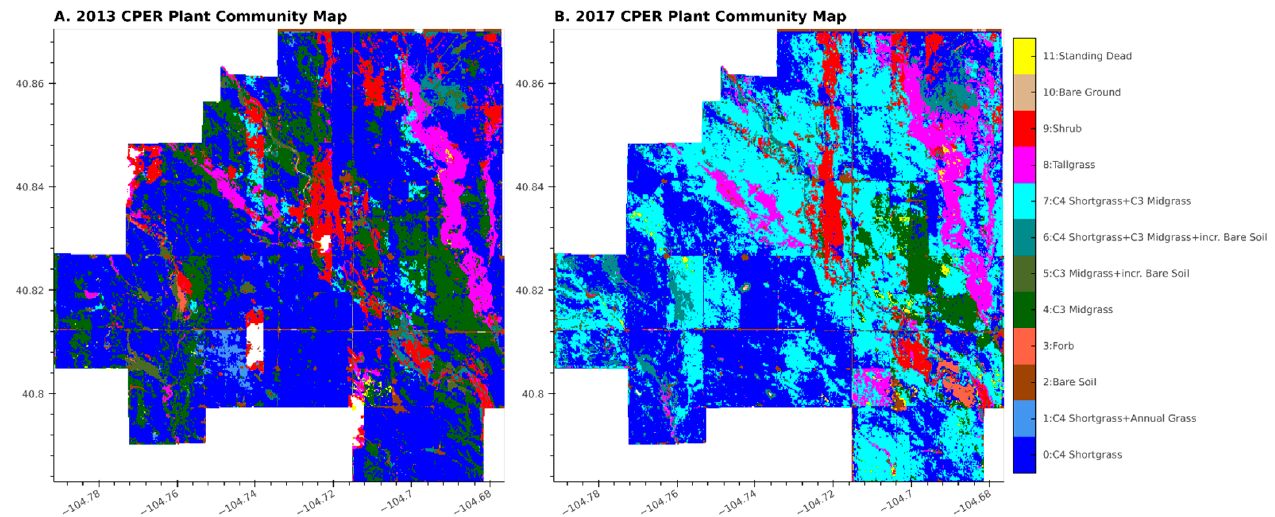
Figure 5. Confusion matrices showing the relative ( A ) and absolute ( B ) results of the SVM model using the validation (hold ‐ out) data. Rows are the actual values, and the columns are the predicted values.